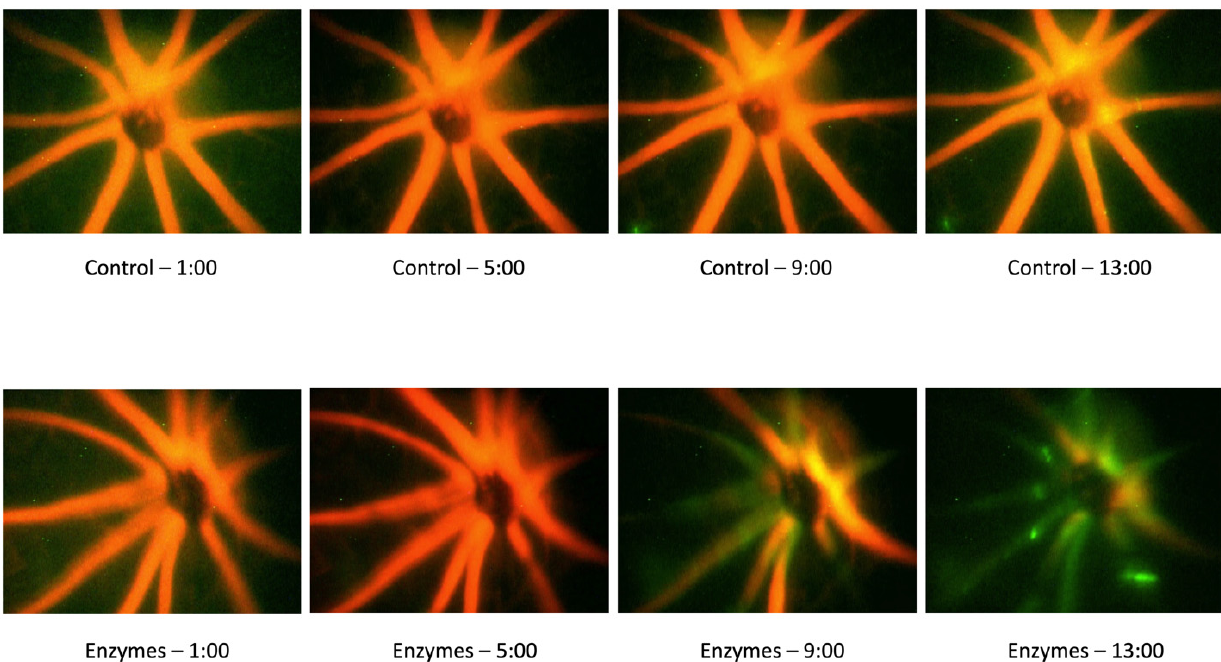
Figure 6. Representative Video Frames from the Thrombosis Experiments. Video frames of a control mouse and a mouse that had been infused with the GAG-degrading enzymes at times of approximately 1, 5, 9, and 13 min following the infusion of the Rose Bengal dye. The loss of red dye indicates the stoppage of flow due to the occlusion of the vessels.